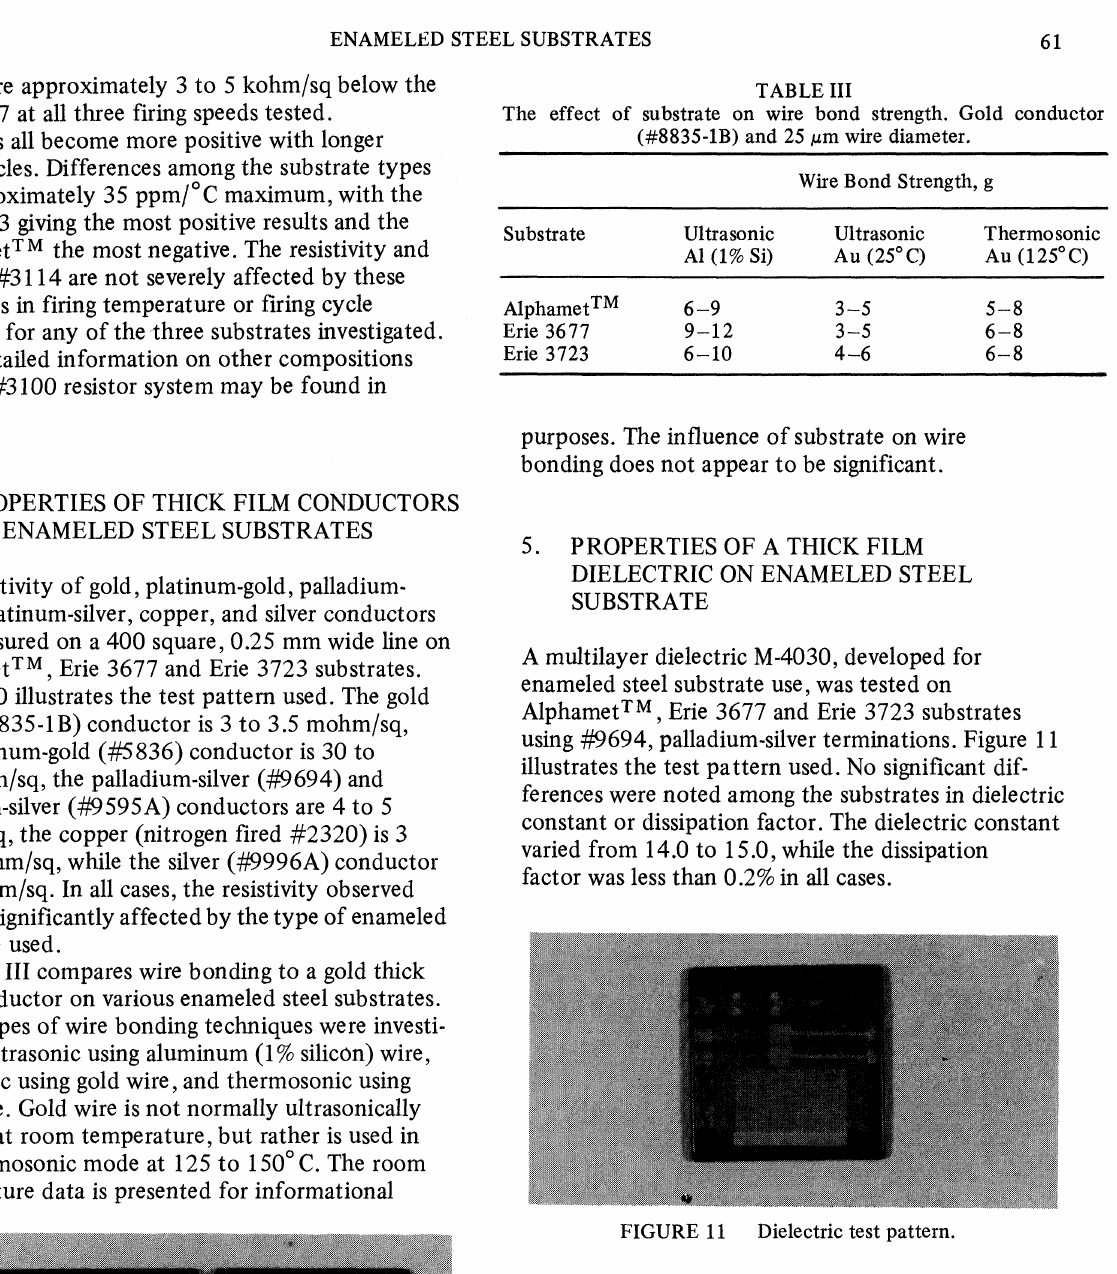
TAB LE III The effect of substrate on wire bond strength. Gold conductor (#8835-1B) and 25 m wire diameter.